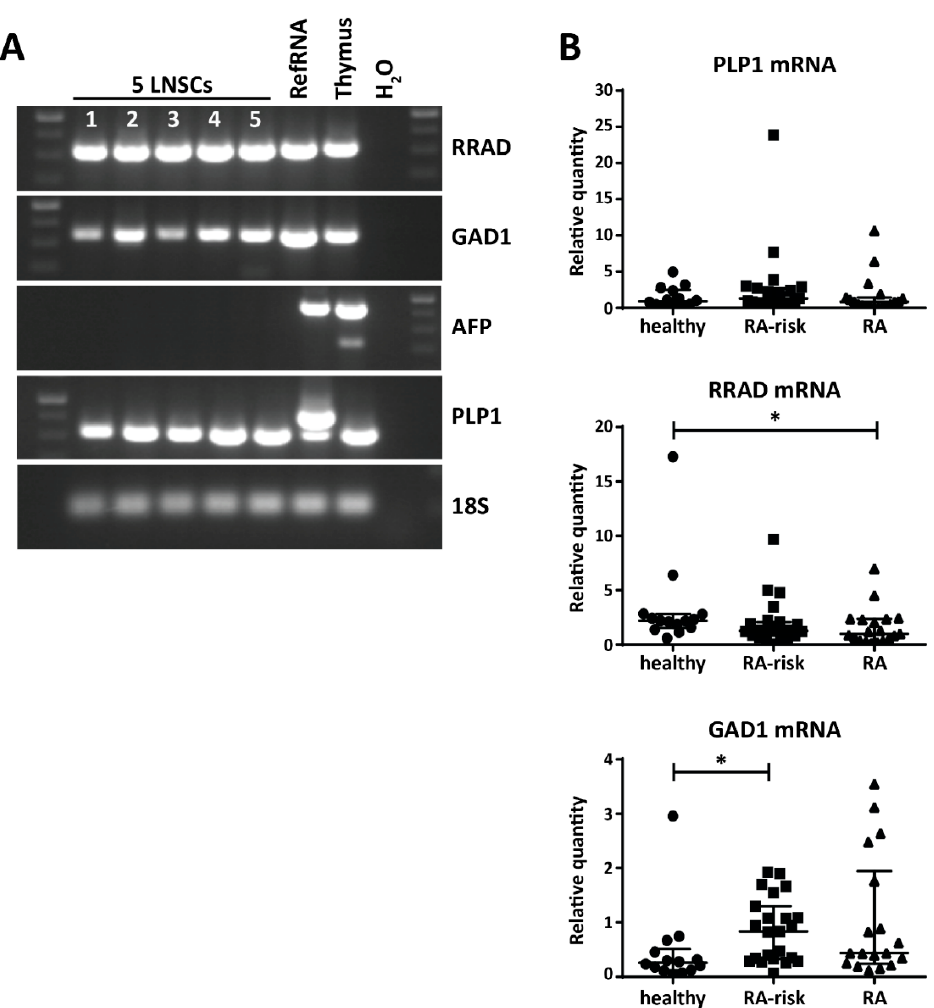
Figure 3. Expression of disease-related PTAs in human LNSCs. ( A ) mRNA expression of Ras Related Glycolysis Inhibitor and Calcium Channel Regulator (RRAD), Glutamate Decarboxylase 1 (GAD1), Proteolipid Protein 1 (PLP1), and Alpha Fetoprotein (AFP) in five LNSC individuals (1: healthy individuals passage 4; 2: RA-risk individuals passage 4; 3: RA patients passage 4; 4: RA patients passage 4; 5: RA patients passage 3) analyzed by PCR and visualized on agarose gel. cDNA prepared from an arbitrary in house-made RNA sample pool containing all human tissues (RefRNA) as well as